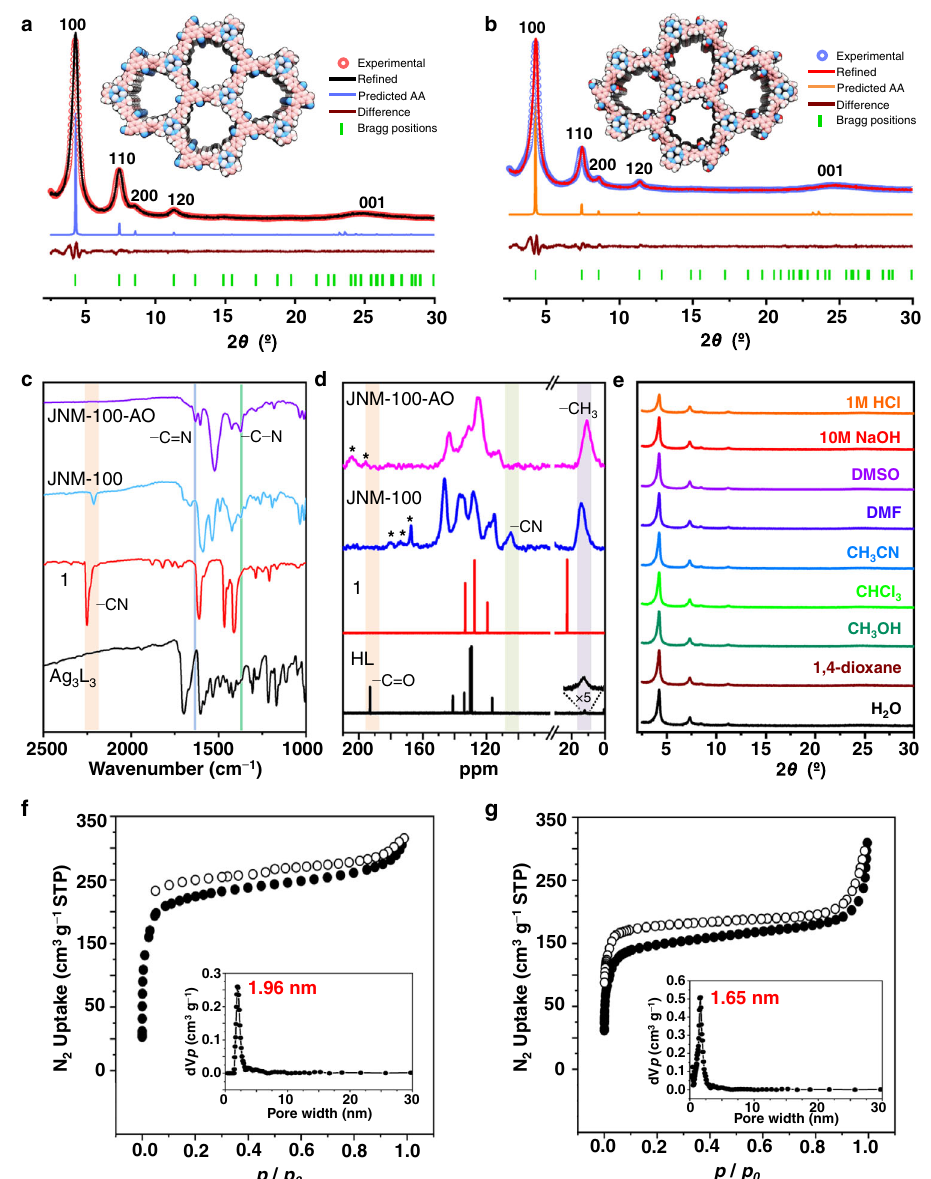
Fig.2|CharacterizationofJNM-100andJNM-100-AO. Crystalstructureof a JNM- 100 and b JNM-100-AO showing space- fi lling model (C, light pink; H, white; Ag, silver; N, sky blue; O, red). c FT-IR spectra of JNM-100-AO, JNM-100, 1, and Ag 3 L 3 . d Solid-state 13 C CP-MAS NMR spectra (100MHz, 300K) of JNM-100-AO, and JNM- 100, and 13 C NMR (100MHz, 300K, DMSO) spectra of linker 1 (red) and ligand HL